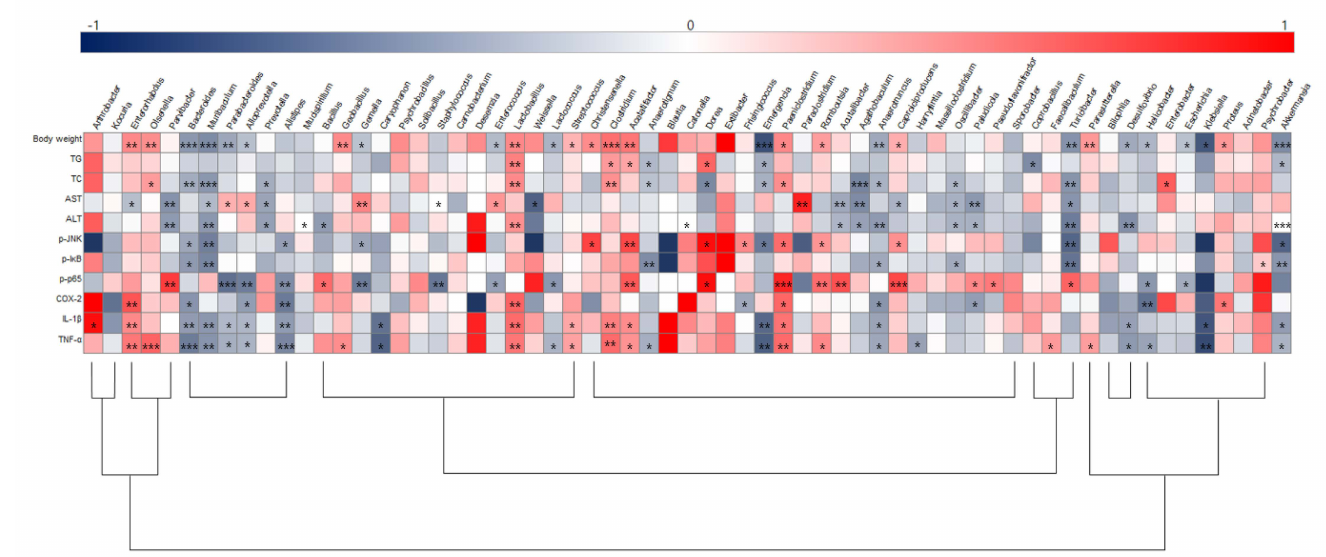
Figure 9. Heatmap of spearman correlation coefficient between key intestinal microbiota and hepatic inflammation traits. The intensity of the color represents the degree of association (dark blue, negative correlation; red, positive correlation). * p < 0.05, ** p < 0.01, and *** p < 0.001. ND, normal diet group; HD, high-fat diet group; SALT, HD with 0.7% salt group; HBM, HD with 10% of HBM Gochujang group; DBM, HD with 10% of DBM Gochujang